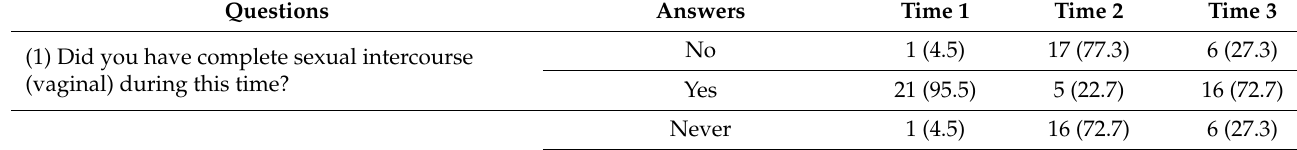
Table 2. Questionnaire administrated to 22 COVID-19 patients before COVID-19 testing (Time 1), during quarantine (Time 2), and 1 month after a negative test (Time